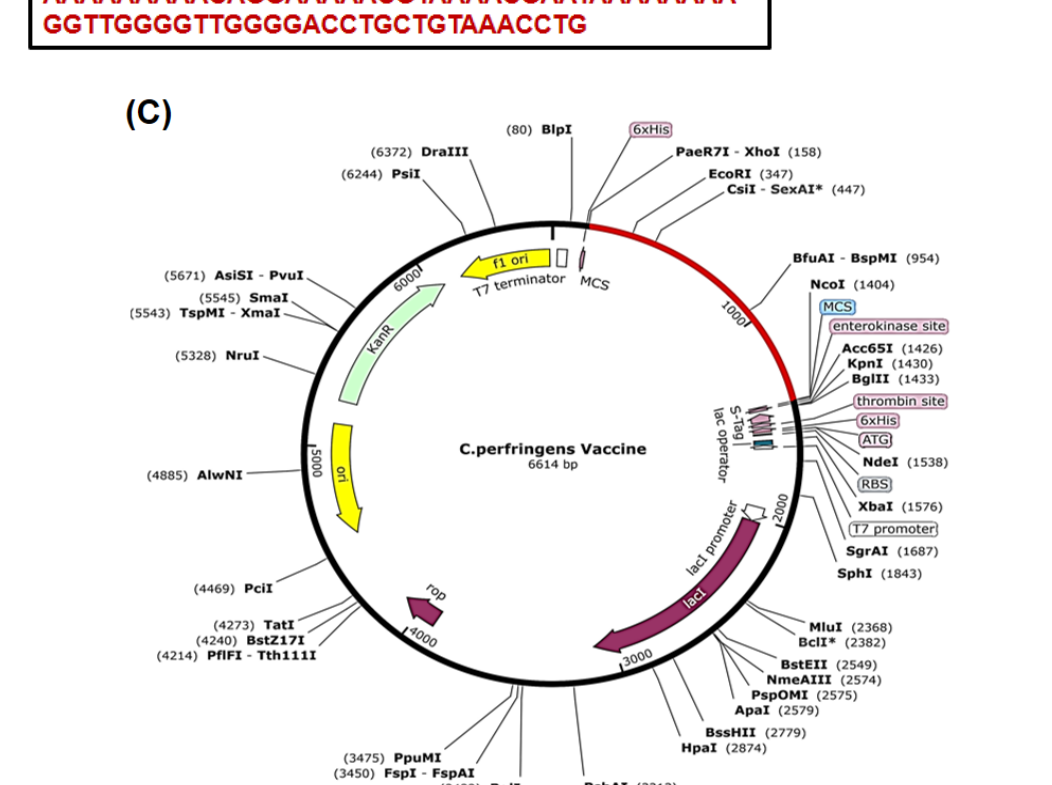
Figure 8. ( a ) Original sequence of MEV; ( b ) optimized DNA sequence; ( c ) codon-optimized MEBV was cloned into the E. coli K12 expression system in-silico. The backbone of the plasmid is shown in black, while the inserted DNA sequence is represented in red; * in-silico.